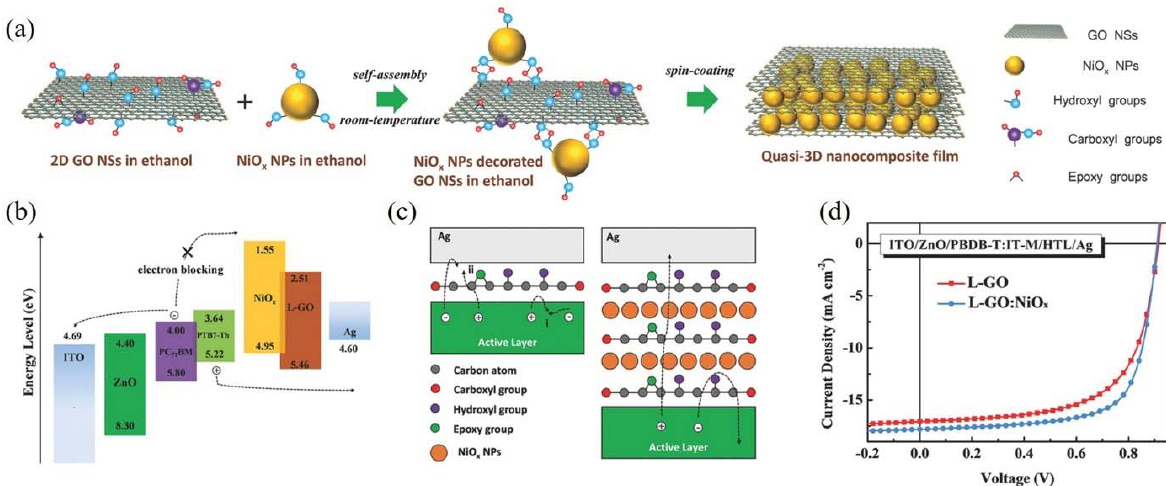
Figure 6. ( a ) Schematic diagram of preparing quasi-3D GO:NiO x nanocomposite; ( b ) Energy levels of materials in OSCs; ( c ) Schematic illustration of carrier extraction and interface dynamics; ( d ) J-V curves of devices based on PBDB-T:IT-M. Reprinted with permission form [87]. Copyright 2018 John Wiley and Sons.